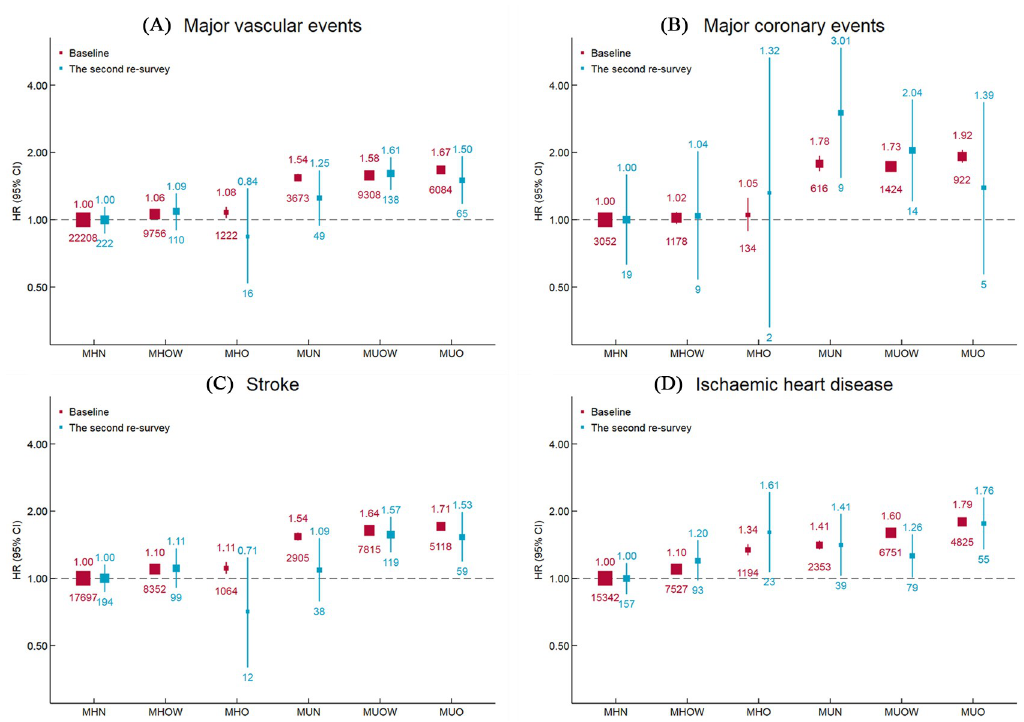
Fig 2. Adjusted HRs for cardiovascular diseases subtypes by BMI-metabolic health status. Values shown are the HR (95% CI) for (A) major vascular events, (B) major coronary events, (C) stroke, and (D) ischemic heart disease, by BMI-metabolic health status. HRs are adjusted for age, study region, sex, education, household income, marital status, smoking, alcohol use, red meat intake, fresh fruits intake, fresh vegetables intake, physical activity, and family history of heart attack or stroke. The values under the squares indicate number of cases in each category. The vertical lines indicate 95% CIs. The size of the squares is proportional to the inverse variance of each effect size. BMI, body mass index; CI, confidence interval; HR, hazard ratio; MHN, metabolically healthy normal weight; MHO, metabolically healthy obesity; MHOW, metabolically healthy overweight; MUN, metabolically unhealthy normal weight; MUO, metabolically unhealthy obesity; MUOW, metabolically unhealthy overweight.